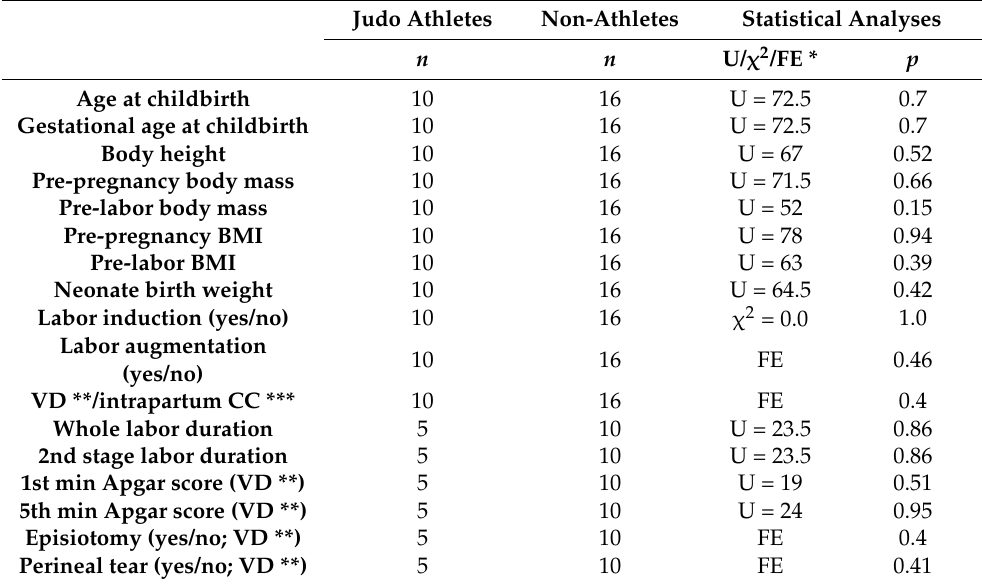
Table 5. Results of comparisons of obstetric characteristics related to first pregnancy and childbirth between elite judo athletes (who stopped their routine training sessions between 0 and 2 months before pregnancy) and non-athletes.